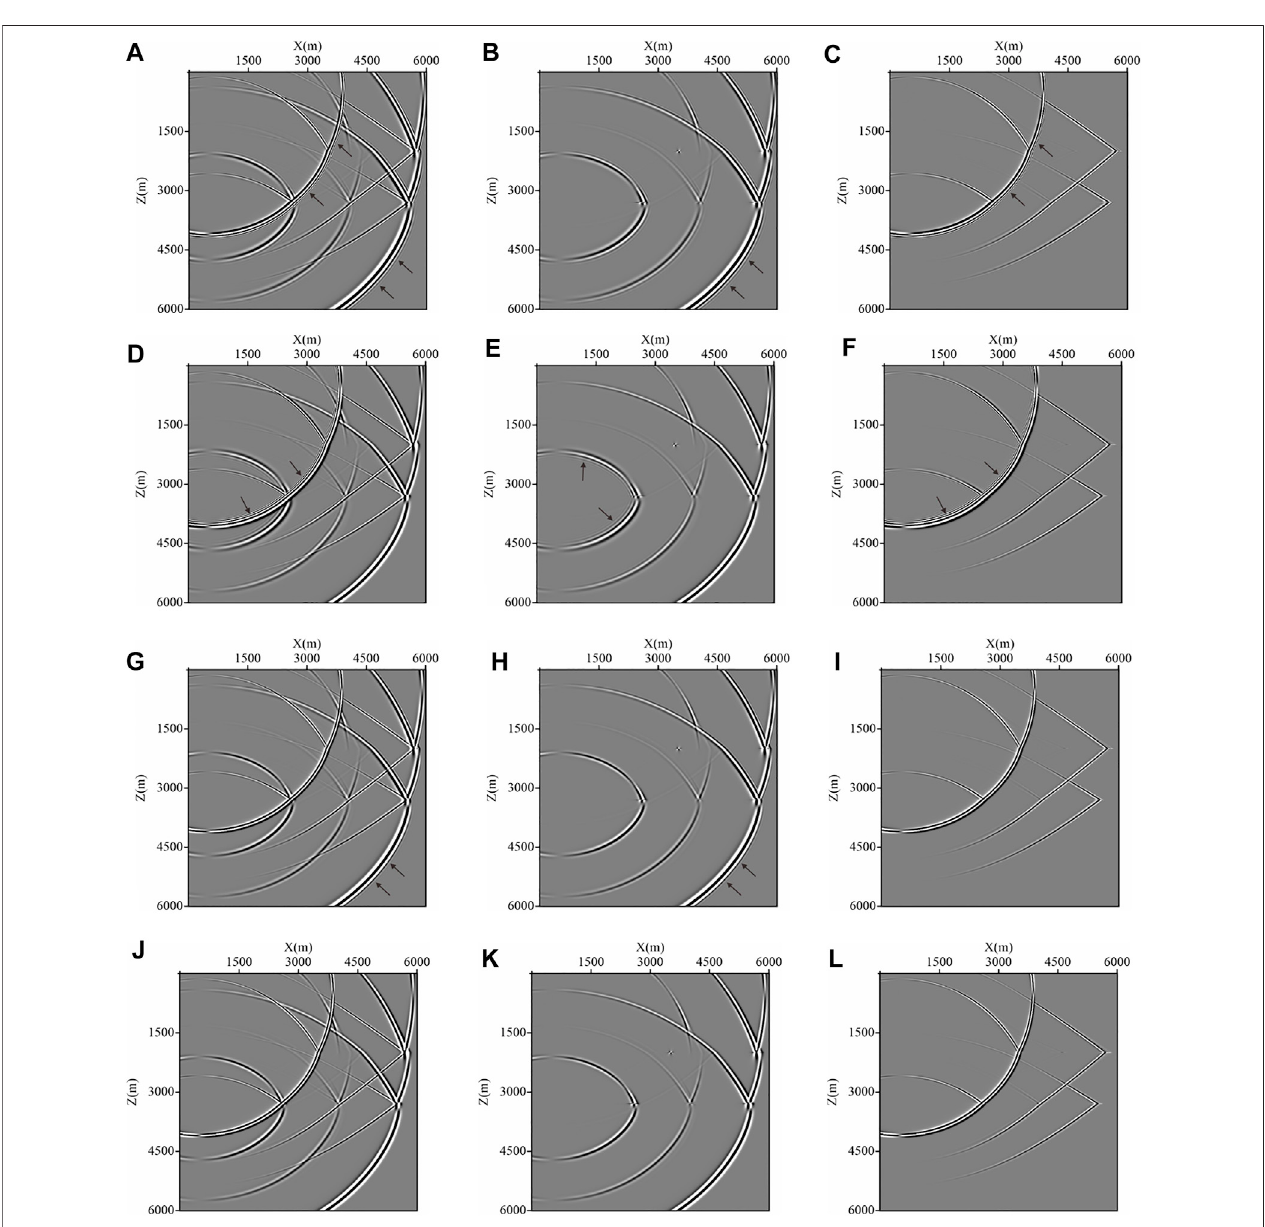
FIGURE10| Elasticsnapshotsof υ z anddecomposedP-andS-wavecomponentsat2.4sforthethree-layeredmodelsimulatedwithtimestep Δ t (cid:2) 1 . 5ms. (A – C) C-SFD( M =10), (D – F), and (G – I) M-SFD( M =8; N =1)withtheFDcoef fi cientscalculatedbasedontheP-andS-wavetime-spacedomaindispersionrelation,respectively. (J – L) M-SFD ( M =8; N =1), solving the decomposed P- and S-wave equations.